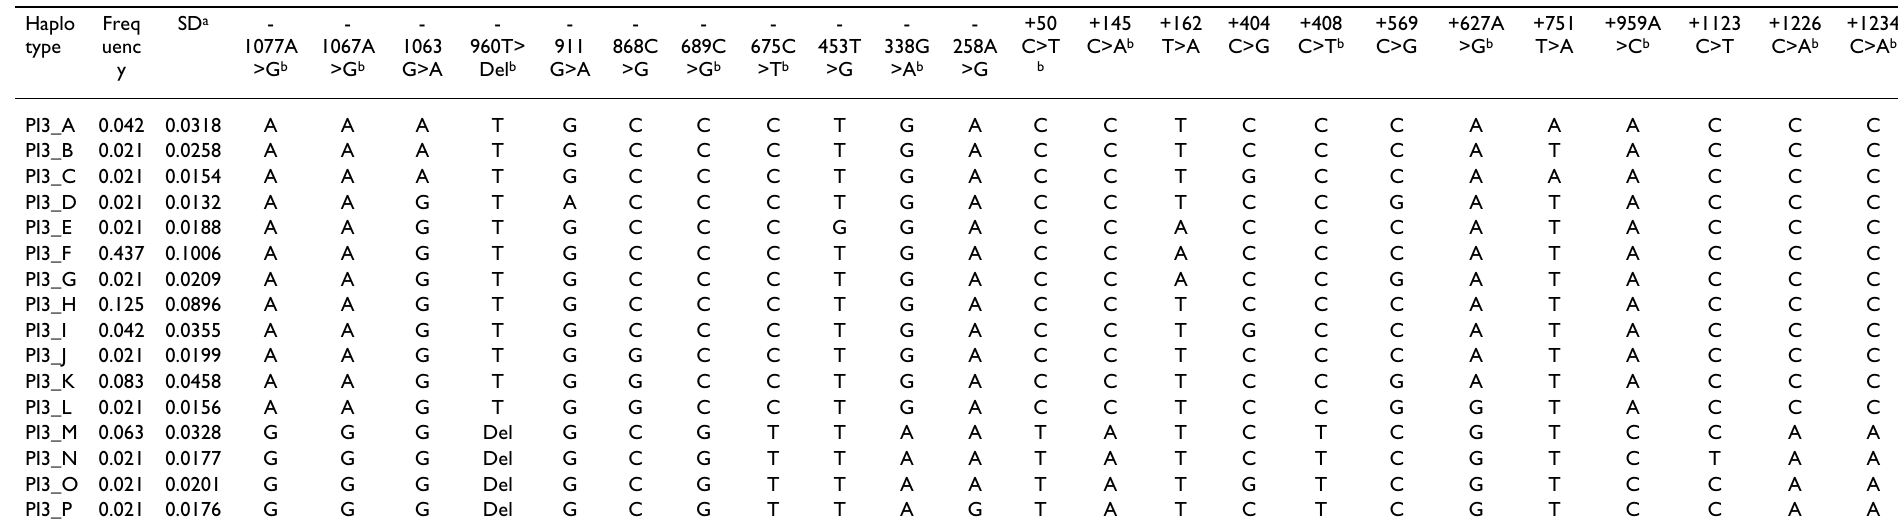
Table 3: Haplotypes constructed with 23 SNPs in the PI3 gene.